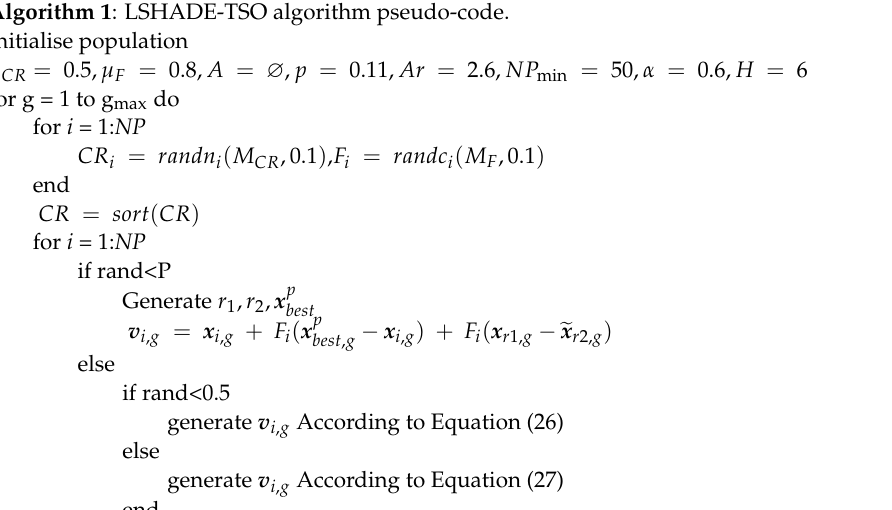
Algorithm 1 : LSHADE-TSO algorithm pseudo-code. Initialise